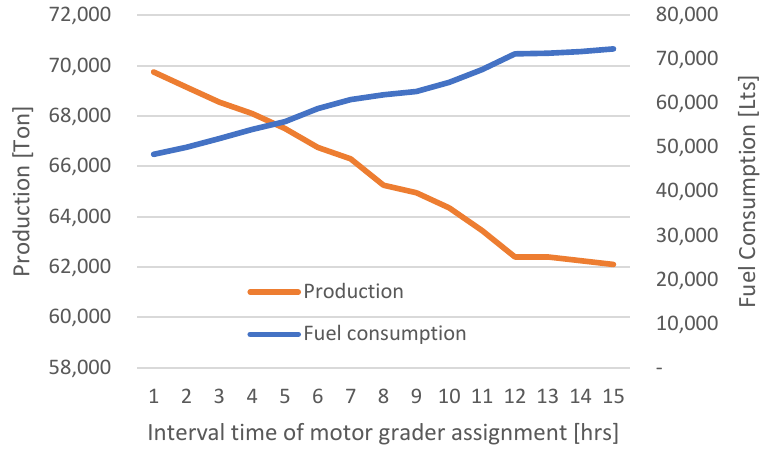
Figure 10. Total production in 24 Hr of operation.